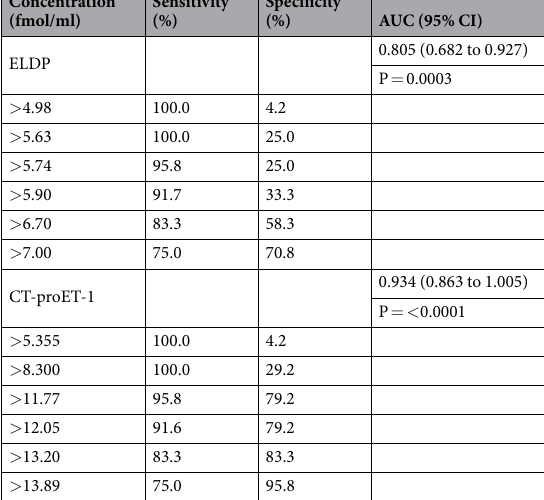
Table 3. ROC analyses for sensitivity and specificity of plasma assays of ELDP and CT-proET-1 for detection of chronic heart failure.